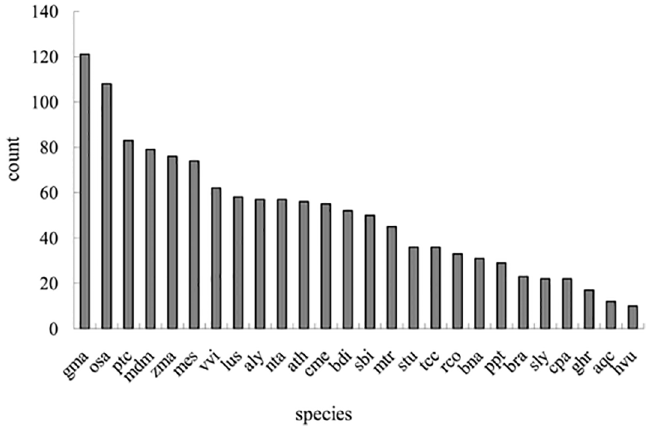
Fig 5. The occurrence of A . catenella miRNAs that appeared also in other selected species. Gma: Glycine max , osa: Oryza sativa , ptc: Populus trichocarpa , mdm: Malus domestica , zma: Zea mays , mes: